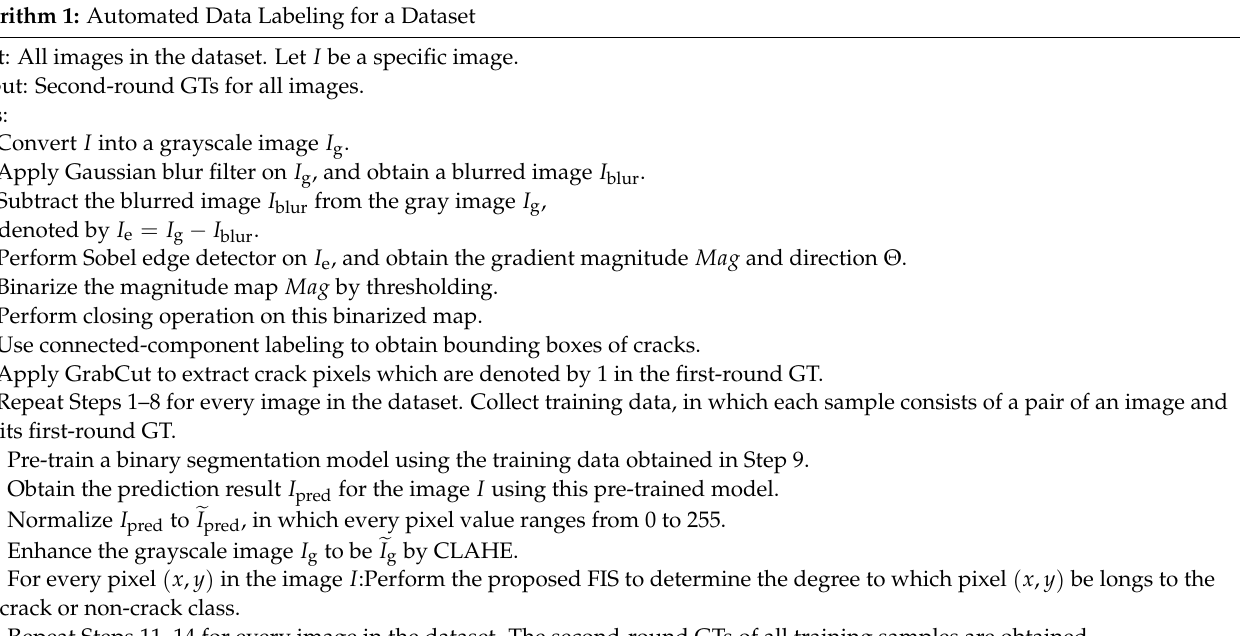
Algorithm 1: Automated Data Labeling for a